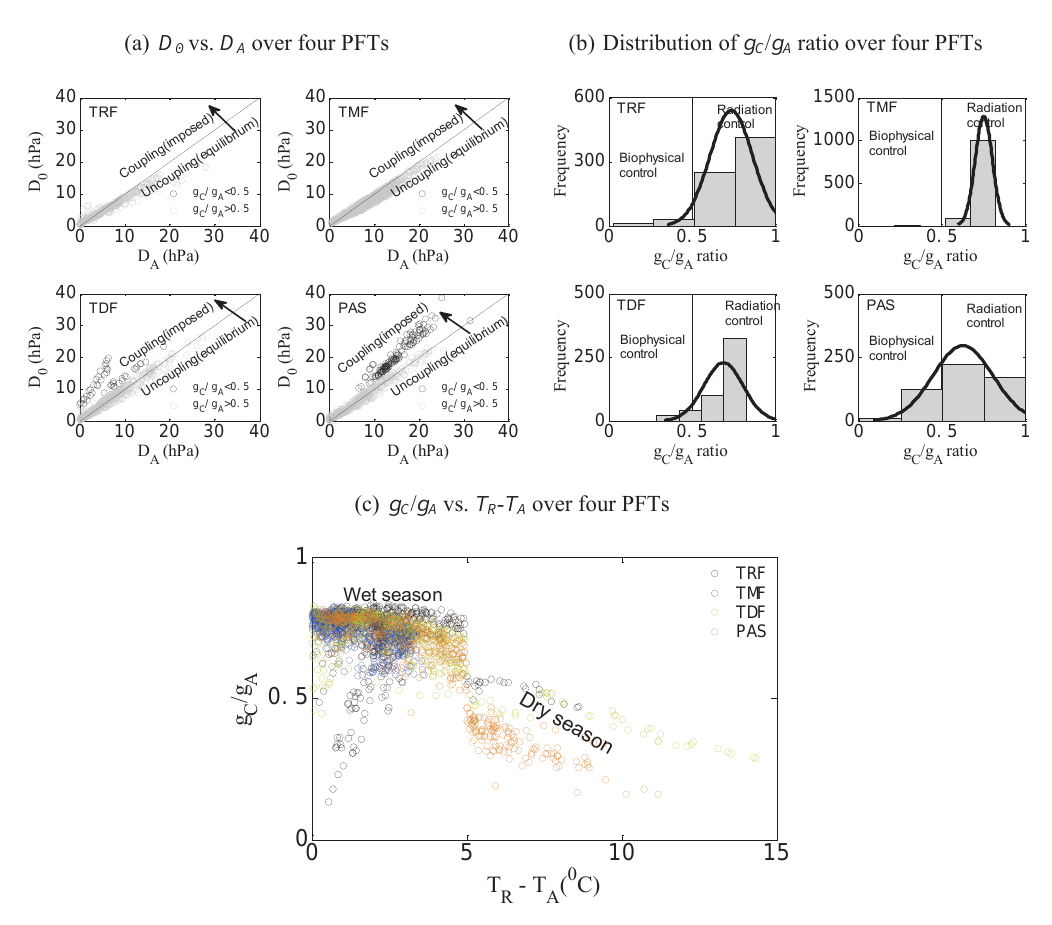
Figure 9. (a) Scatter plots between source/sink height (or in-canopy) vapor pressure deficit ( D 0 ) and atmospheric vapor pressure deficit ( D A ) for two different classes of g C / g A ratios over four PFTs, which clearly depicts a strong coupling between D 0 and D A for low g C / g A ratios. (b) Histogram distribution of g C / g A ratios over the four PFTs in the Amazon Basin (LBA tower sites). (c) Scatter plots between g C / g A ratio vs. surface air temperature difference ( T R − T A ) for the four PFTs during the wet season and dry season in the Amazon Basin (LBA tower